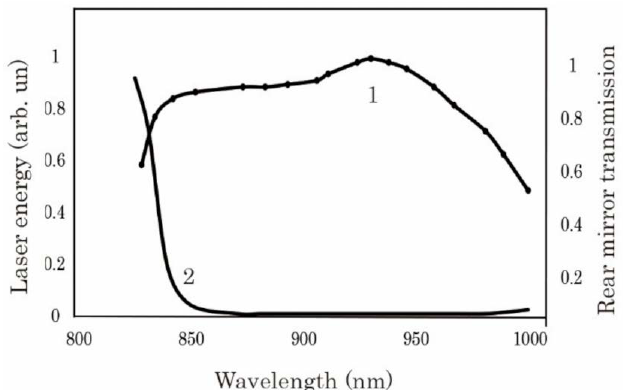
Figure 2. Wavelength dependence of Ti:Sapphire laser energy (1) and reflection coefficient of rear mirror (2). Reprinted with permission from ref. [8]. Copyright 2015 © The Optical